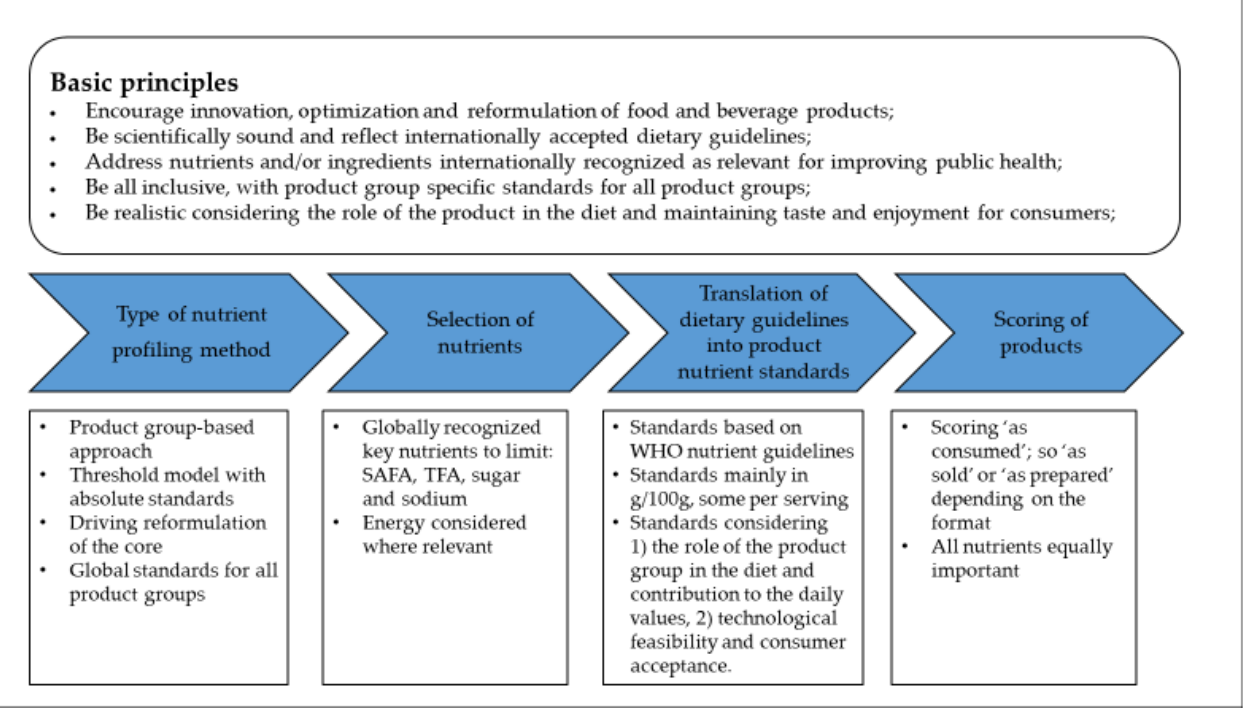
Figure 1. Schematic approach for setting the Unilever standards for nutrients to limit.